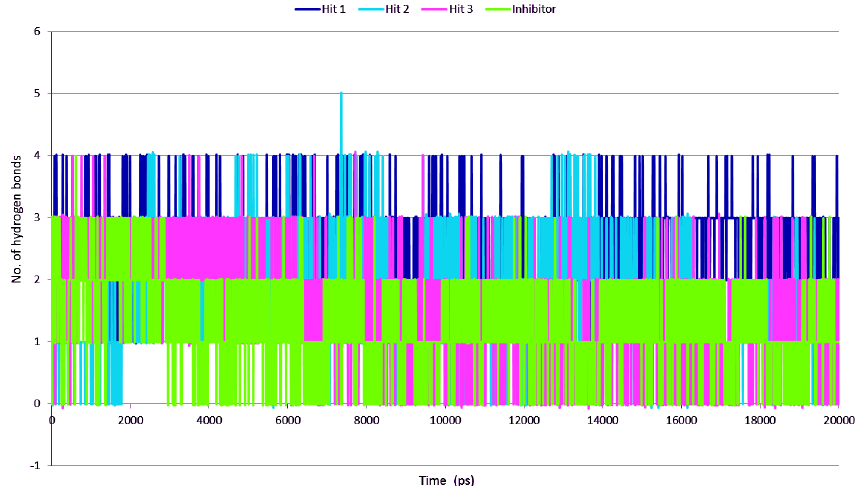
Fig 10. The number of intermolecular hydrogen bonds between protein and compound during 20 ns MD simulations. Blue, cyan, pink, and green colors represent Hit1, Hit2, Hit3, and Inhibitor